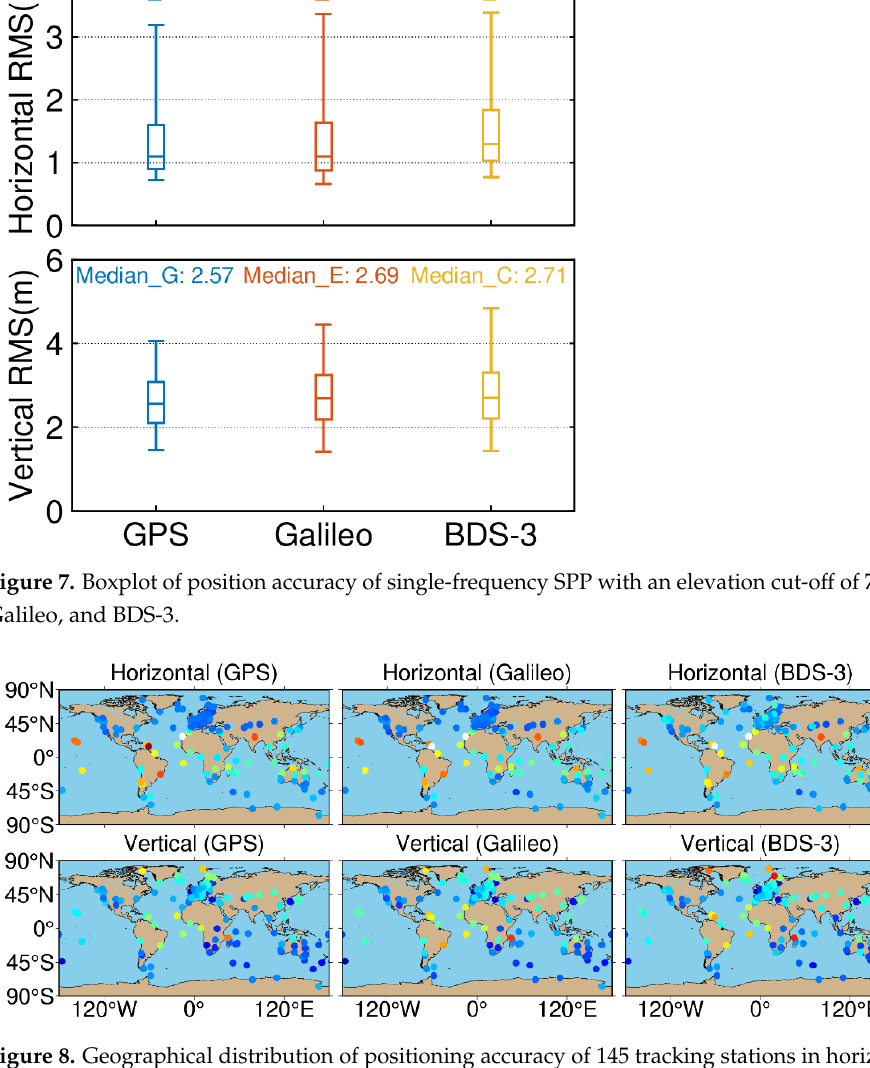
Figure 8. Geographical distribution of positioning accuracy of 145 tracking stations in horizontal and vertical components with an elevation cut-off of 7° for GPS, Galileo, and BDS-3.